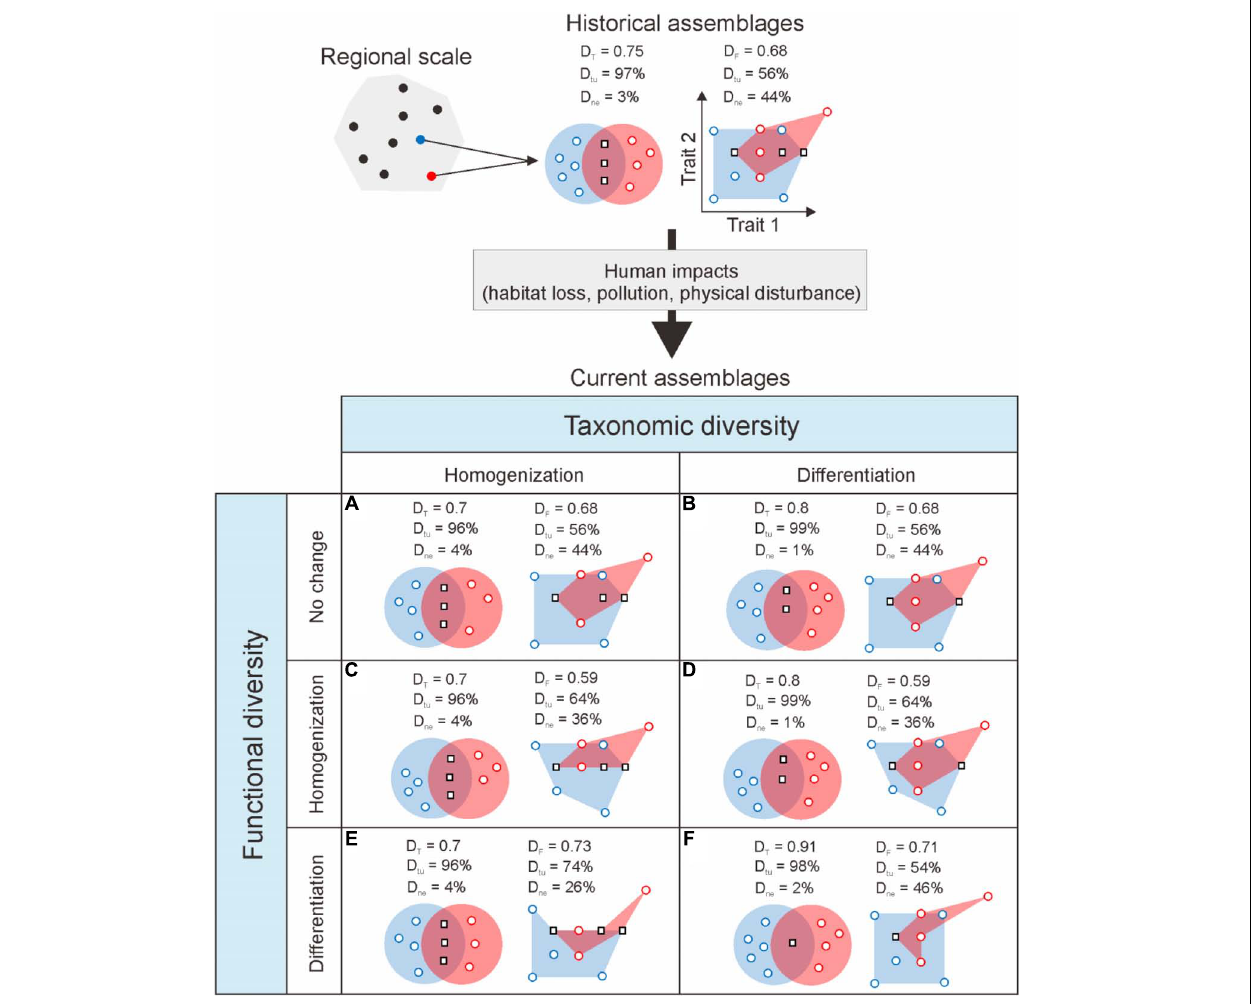
FIGURE 1 | Schematic of possible temporal changes in taxonomic ( D T ) and functional ( D F ) dissimilarity between a pair of theoretical species assemblages resulting from the loss of species under human impact (adapted from Villéger et al., 2014). By modifying existing environmental conditions, resource availability, biotic interactions and dispersal processes, human activities are expected to alter the taxonomic and functional composition of assemblages. For simplicity, here those effects are represented as the loss of two species from the original assemblages comprising eight and six species of which three are common to both assemblages. Species assemblages are represented by the red and blue envelopes containing the individual species symbolized by circles (species unique to one assemblage) and squares (shared species). Taxonomic and functional similarity are, respectively, illustrated by the intersection of ellipses, following the classical Venn diagram representation, and minimum convex hulls including all species in an assemblage in a multidimensional functional space (here represented by two traits). Taxonomic homogenization (A,C,E) results from the loss of unique species. Conversely, taxonomic differentiation (B,D,F) occurs following the loss of shared species from the assemblages. Depending on the functional role of the species lost, changes in taxonomic diversity may lead to changes in functional diversity of the same sign (C,F) , the opposite sign (D,E) , or produce no change (A,B) . Where immigration through dispersal is possible, the arrival of new species from other assemblages may buffer or exacerbate these effects. Changes in dissimilarity can be decomposed into two complementary components related to differences in species richness between assemblages (nestedness; D ne ), and the number of species replaced between assemblages independent of differences in species richness (turnover; D tu